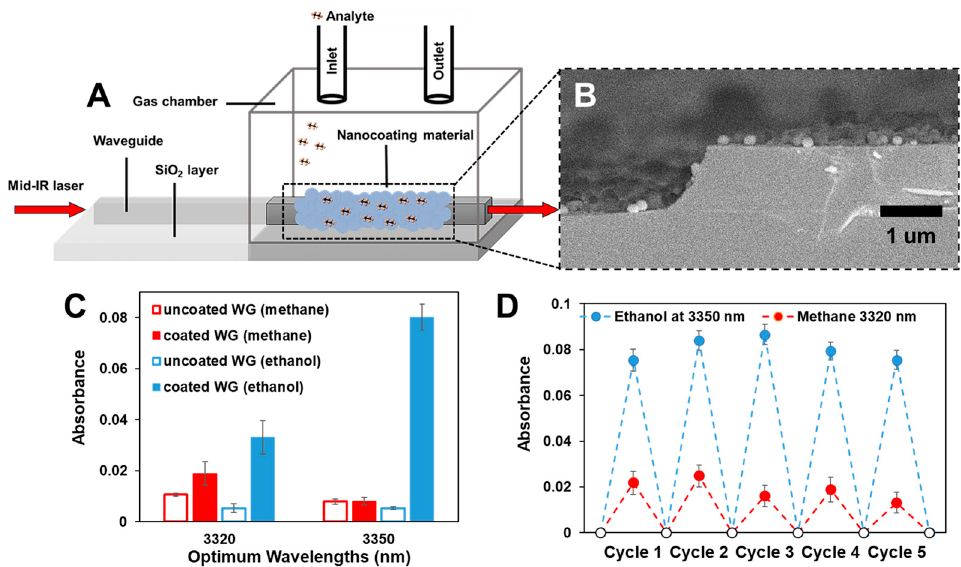
Figure 5. Schematic representation of an optical waveguide sensor ( A ); cross-sectional SEM image of functionalized waveguide with calcinated 1-BL film ( B ); graph showing absorbance of ethanol and methane for 1-BL film coated and uncoated WGs at their optimum wavelengths 3350 and 3320 nm, respectively ( C ) and graph showing reversibility measurements of ethanol and methane at their optimum wavelengths ( D ).